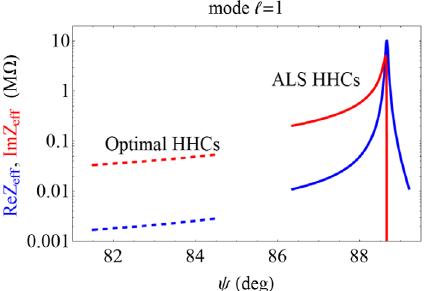
The accuracy of (49) as judged from Fig. 1, dashed curve, is not as good as that of (45) as j greater than unity and the asymptotic approximation not fully valid.